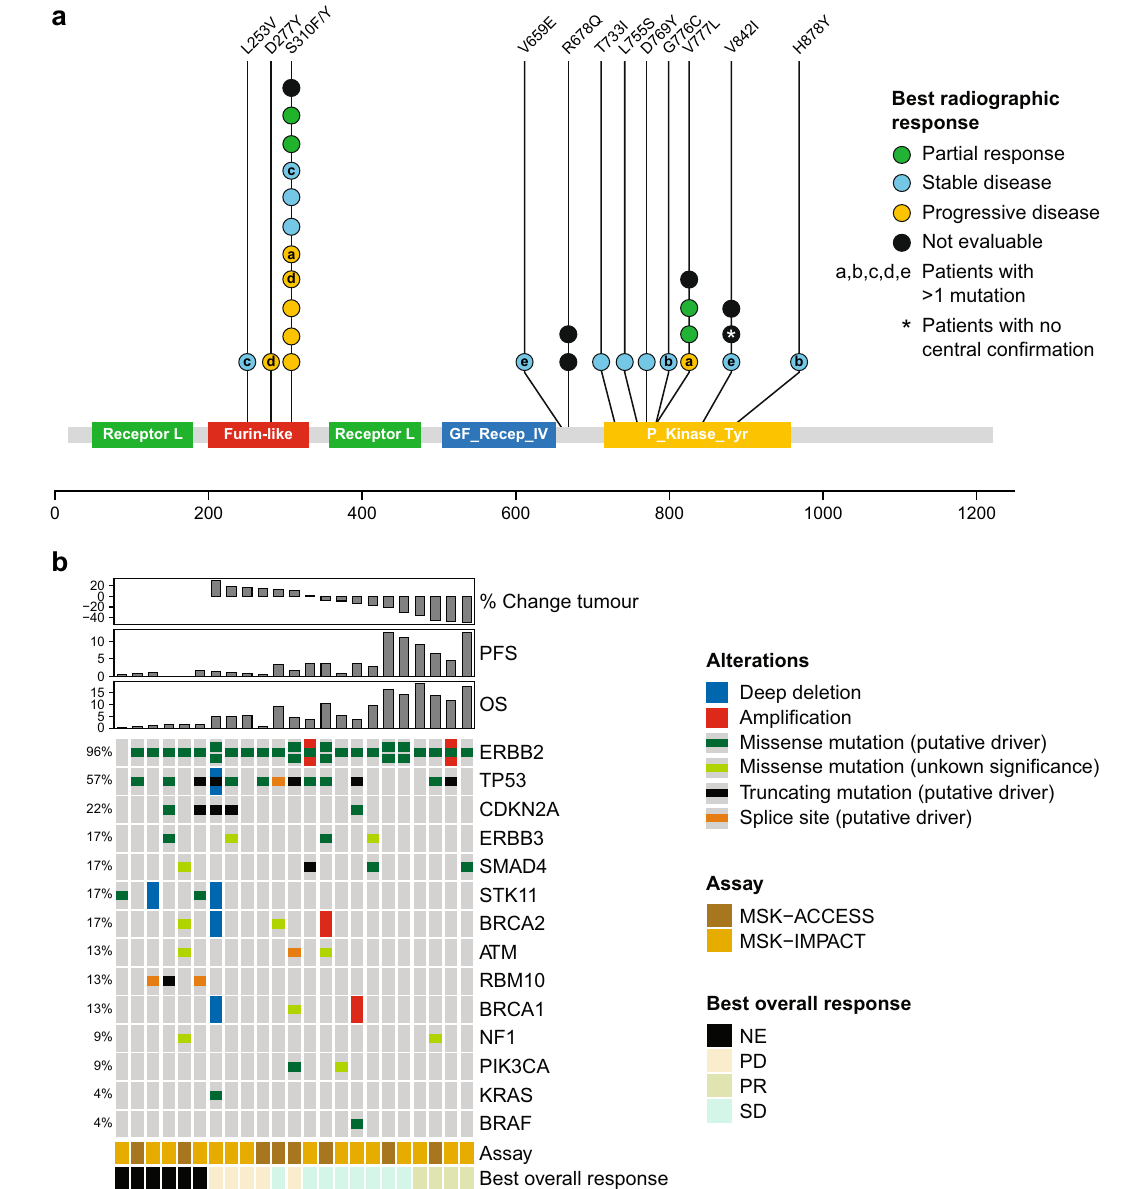
Fig. 4 | Genomic determinates of response to neratinib ( n =23). a Lollipop dia- gram of the HER2 gene annotated with centrally con fi rmed mutations and tumour responses.Letterswithincirclesindicatematchingsamples,i.e.,patientswithmore than one mutation; b OncoPrint of co-occurring genomic alterations